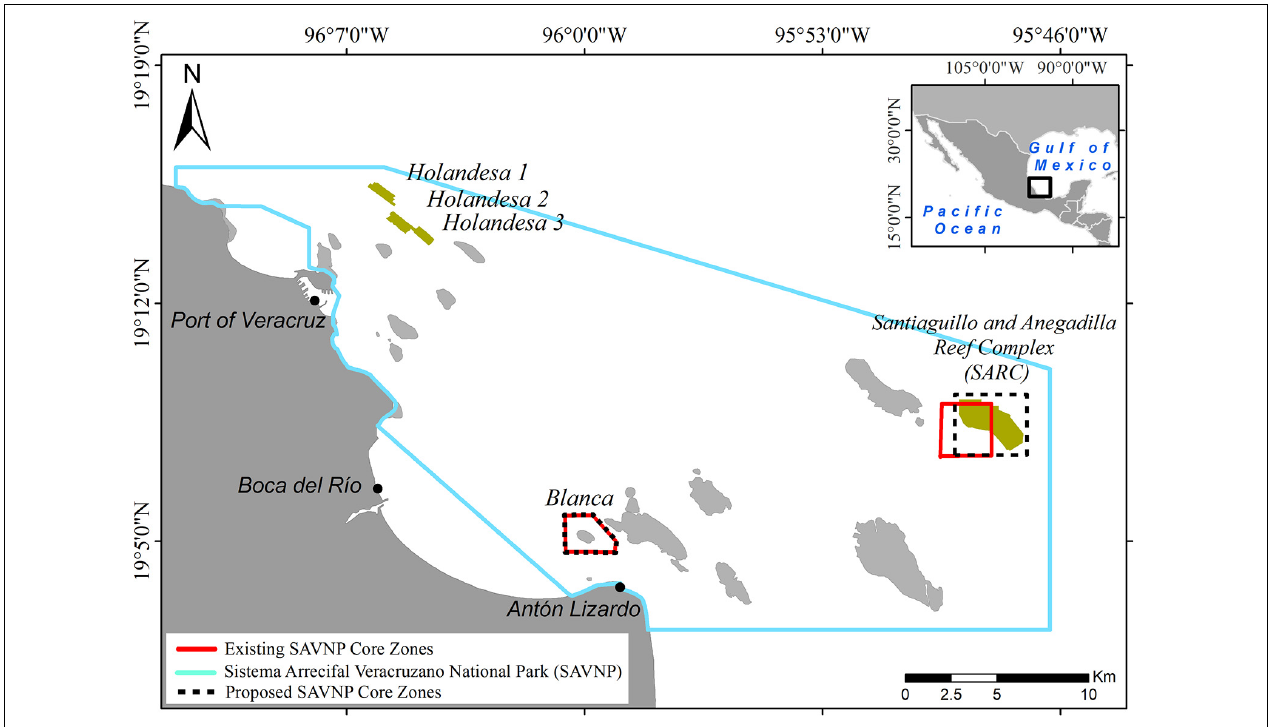
FIGURE 1 | Sistema Arrecifal Veracruzano National Park (SAVNP) located in the southwestern Gulf of Mexico; the two groups of reefs studied are highlighted. Polygons in red indicate core zones; polygons in dashed line indicate the proposed core